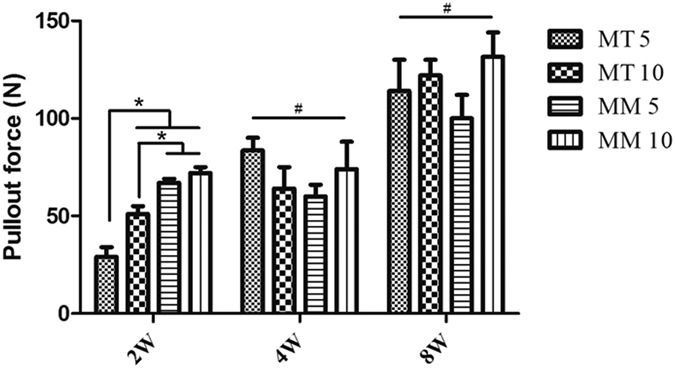
Pullout force of different groups.*p < 0.05; #p > 0.05.